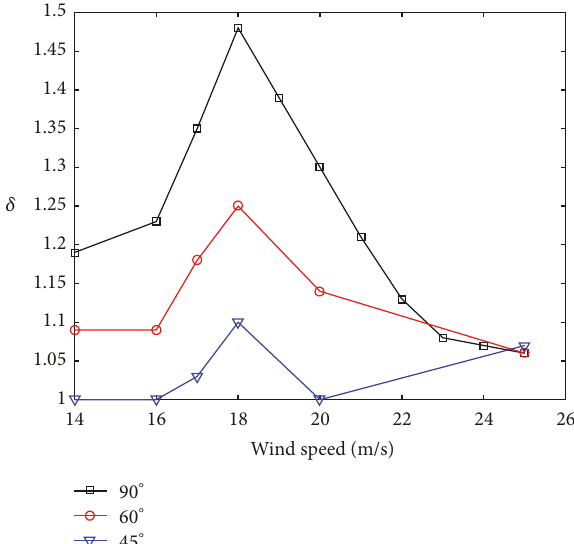
Figure 26: Comparison of the 𝛿 results of the members near the tower bottom under different wind speeds and wind